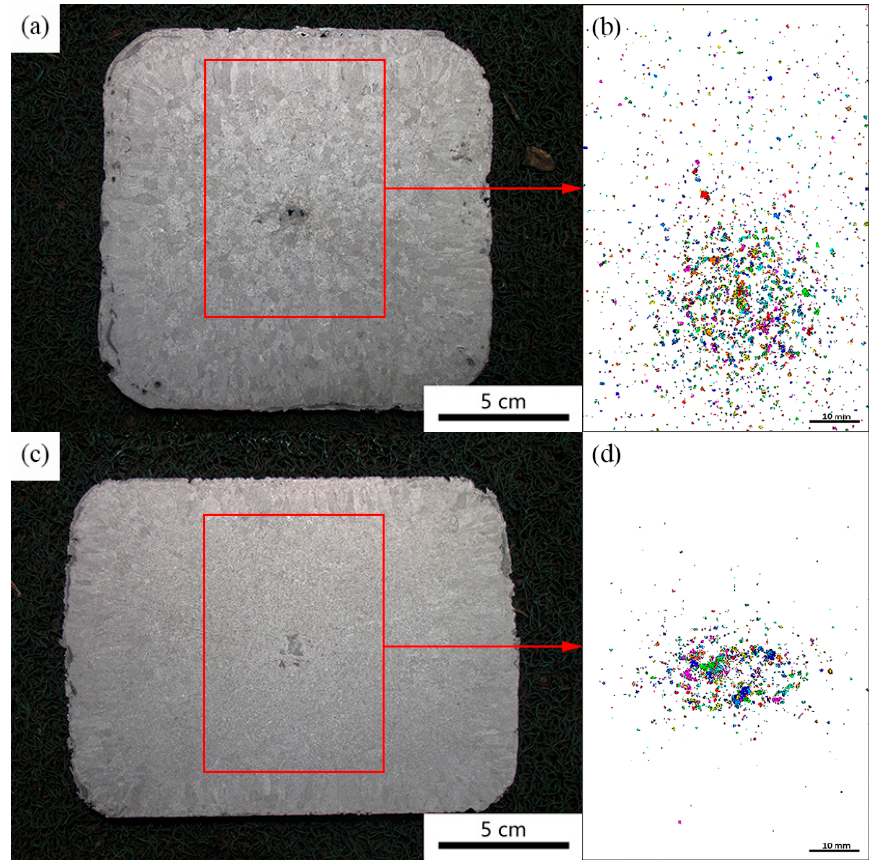
Figure 4. Defect characterization of billets: ( a ) macro-void distribution of Billet A; ( b ) micro-void distribution of Billet A; ( c ) macro-void distribution of Billet B; ( d ) micro-void distribution of Billet